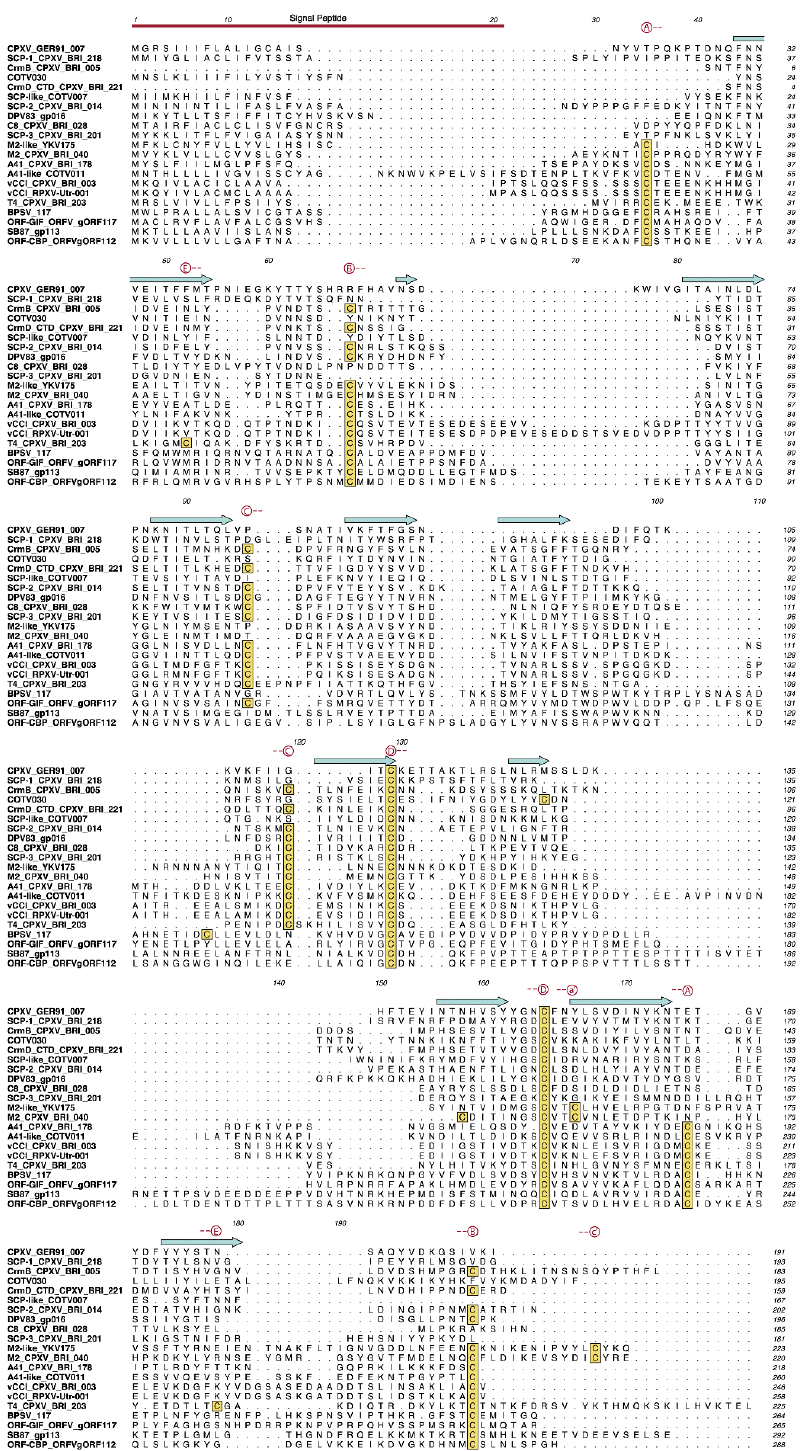
Figure 6. Sequence alignment of representative members of the PIE families. The positions of the vCCI core strands (cyan) are shown above the sequences. Cysteines are boxed in yellow. The predicted disulfide bonds are lettered in red. The predicted signal peptides are shown under the red bar. The PIE family name is given before the ORF name when they differ.